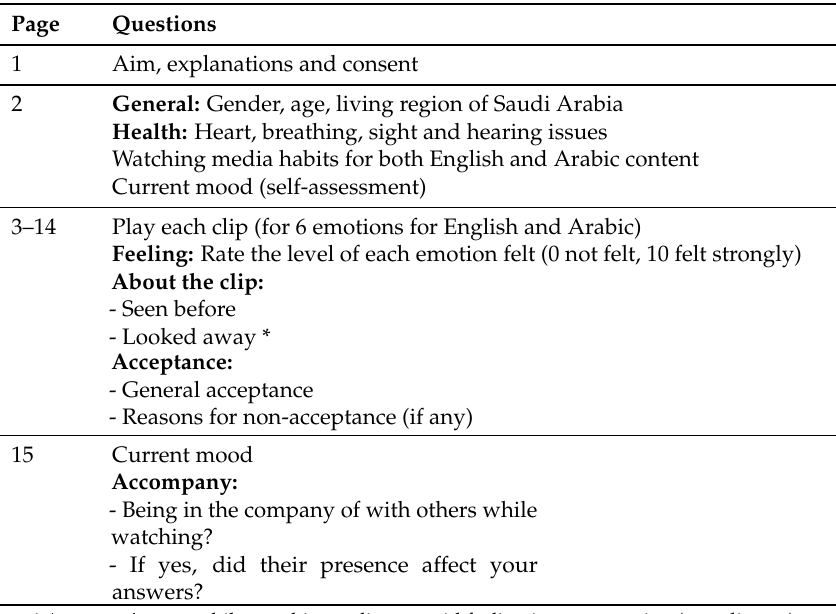
Table 2. List of questions in the online